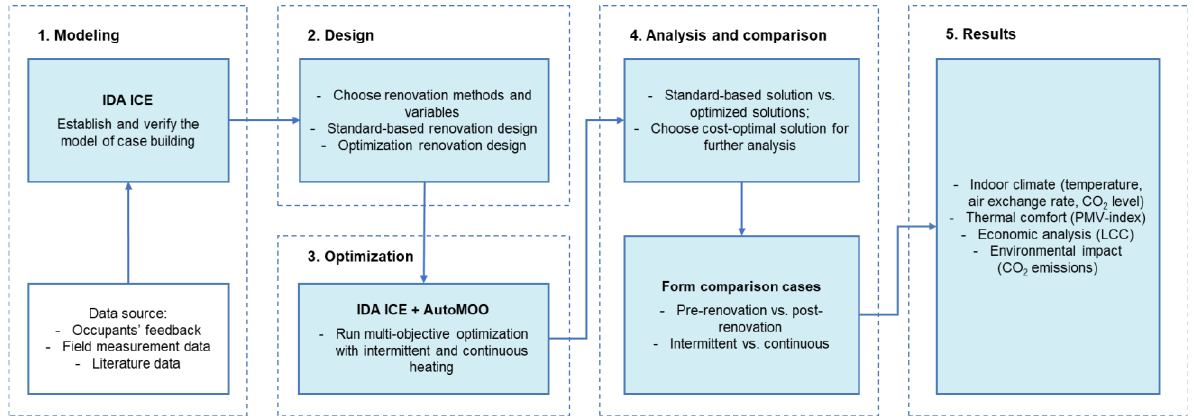
Figure 1. General progress scheme in analysis.